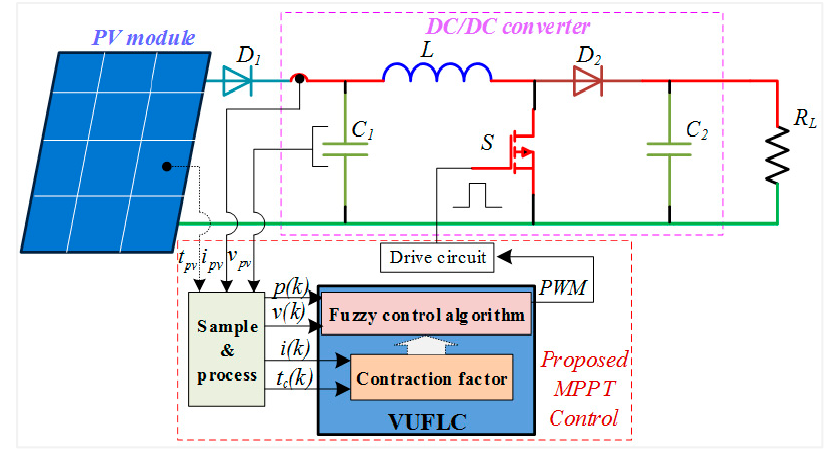
Figure 6. Block diagram of the PV MPPT control system.